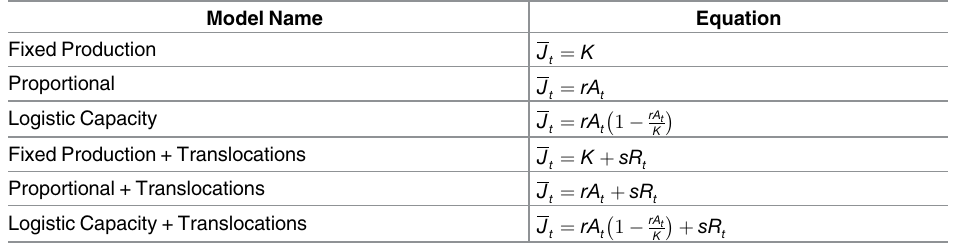
Table 3. Competing statistical models for YOY Abundance in October.